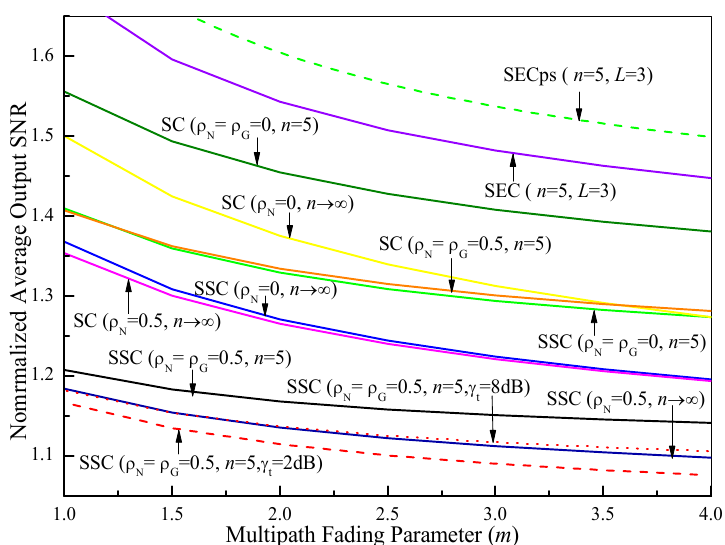
Figure 1. Comparison of the normalized average output SNR values of SCC ( 𝛾̅ (cid:3020)(cid:3004)(cid:3004) 𝛾̅ ⁄ ), PSC ( 𝛾̅ (cid:3020)(cid:3004) 𝛾̅ ⁄ ), SEC ( 𝛾̅ (cid:3020)(cid:3006)(cid:3004) 𝛾̅ ⁄ ), and SECps ( 𝛾̅ (cid:3020)(cid:3006)(cid:3004)(cid:3043)(cid:3046) 𝛾̅ ⁄ ) as functions of the multipath fading parameter ( m ) over Fisher– Snedecor ℱ and Nakagami ‐ m ( n → ∞ ) fading channels, where 𝛾̅ = 5 dB and γ (cid:3099) = 5 dB.